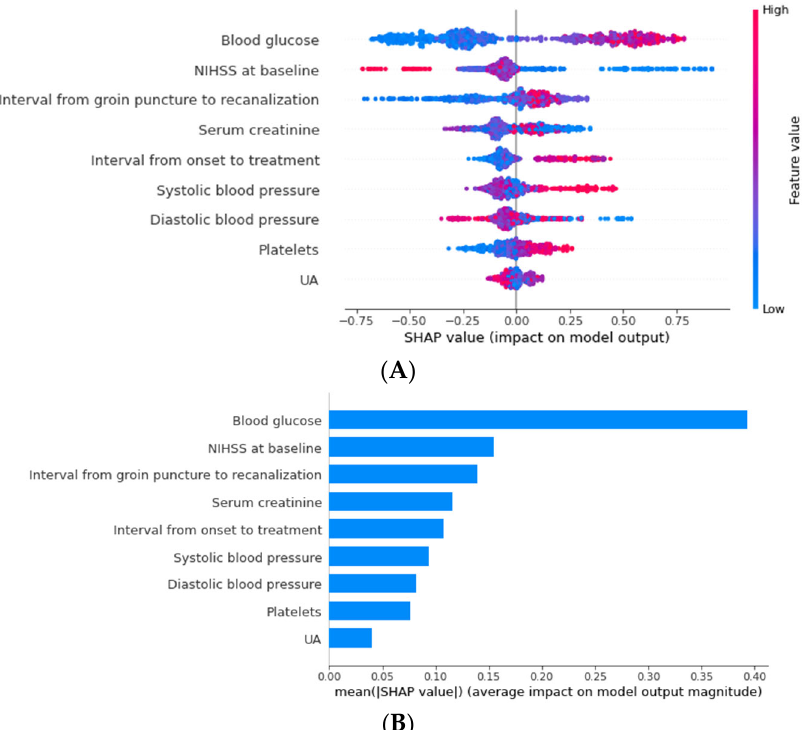
Figure 4. Feature importance ranking based on Shapley Additive Explanation (SHAP) values. Red indicates that the value of the feature is high, and blue indicates that the value of the feature is low; the x-axis represents the SHAP values; the features are ranked according to the sum of the SHAP values for all patients ( A ). Standard bar charts were drawn and sorted using the average absolute value of the shape values of each feature in model ( B ).